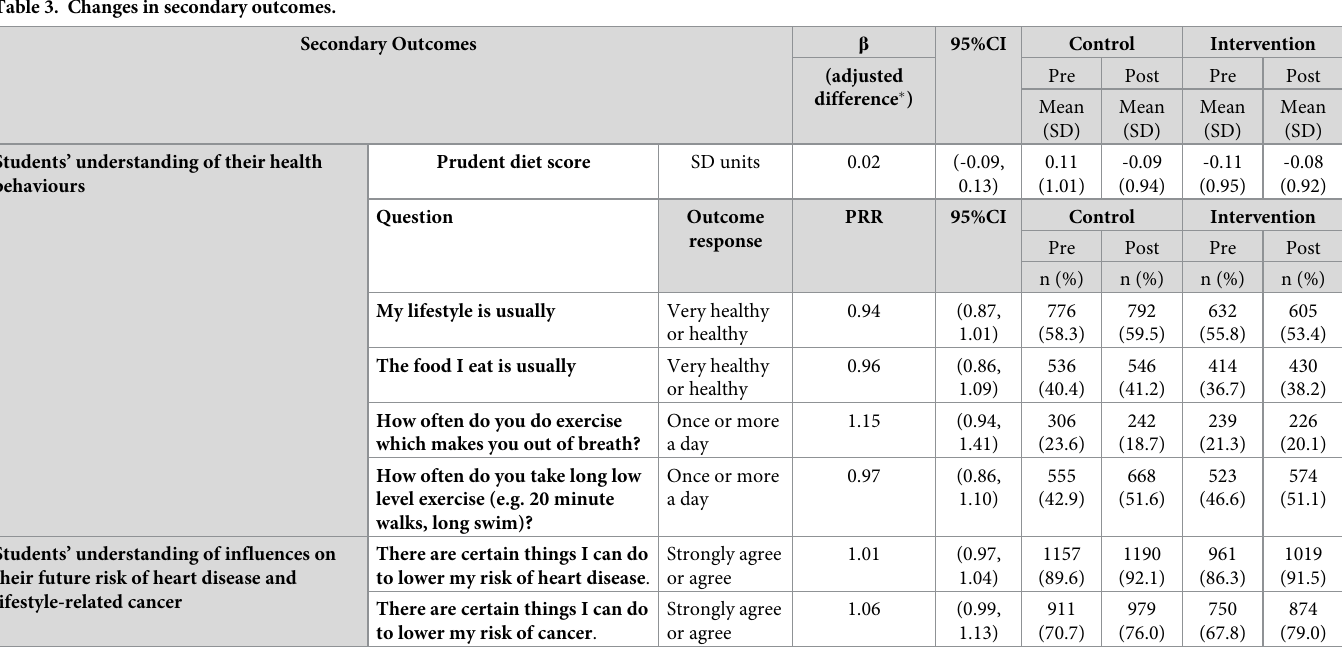
Table 3. Changes in secondary